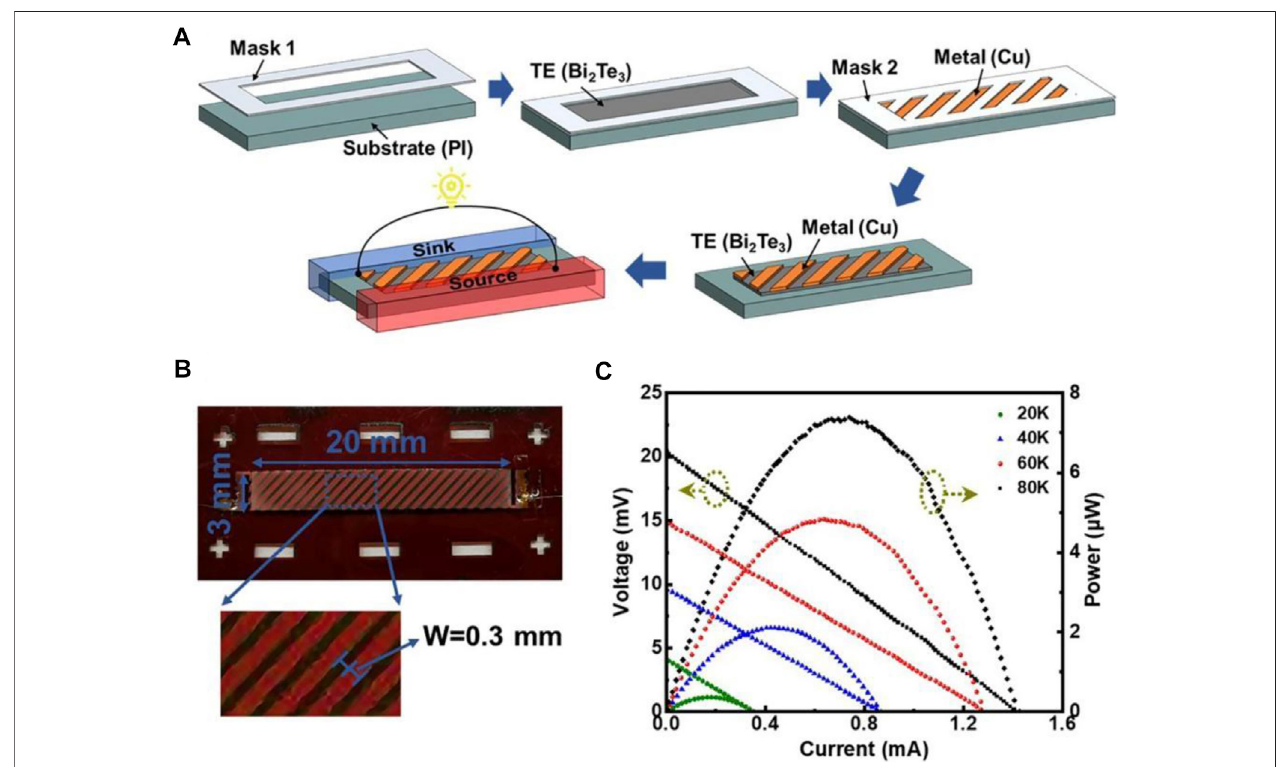
FIGURE 3 | (A) Preparation process of the transverse thin- fi lm thermoelectric device by mask-assisted deposition. (B) Photograph of the Bi 2 Te 3 /Cu tilted thin- fi lm thermoelectric device. (C) Output performances ofthe Bi 2 Te 3 /Cu tilted thin- fi lm thermoelectricdevice at different temperature differences Δ T z ( Δ T z = T hot – T cold and T cold = 293